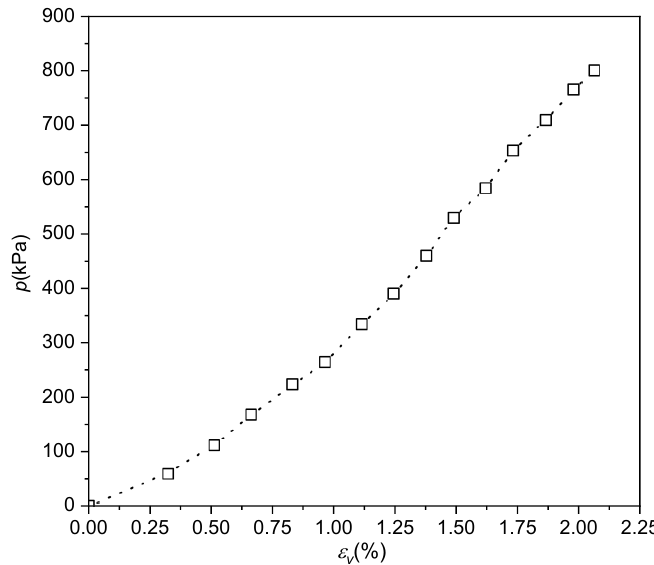
Figure 8. Curve of standard consolidation test of sandy gravel soil sample.